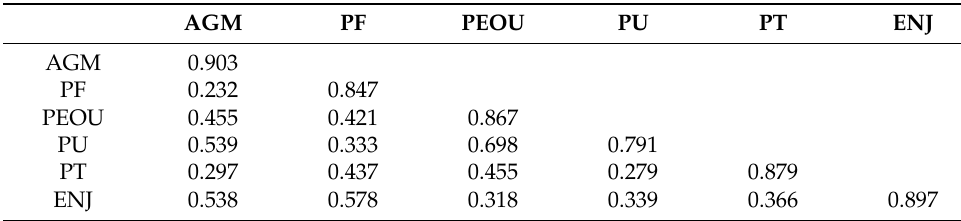
Table 6. Fornell-Larcker scale.